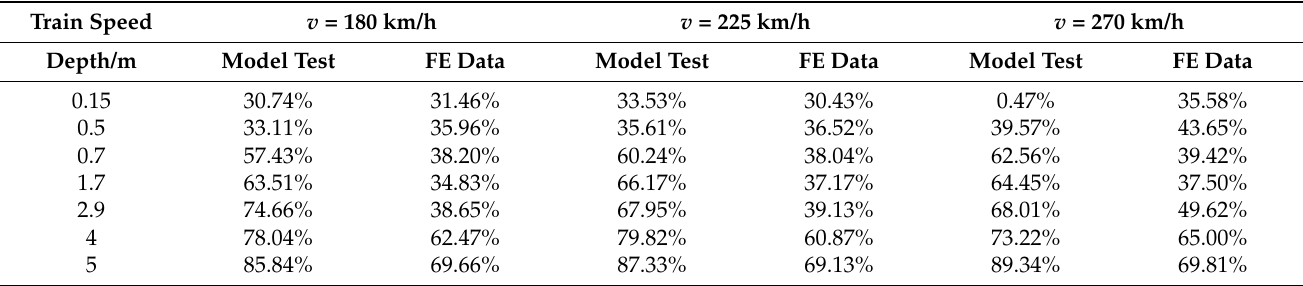
Table 10. Vibration attenuation ratio of the velocity along depth.